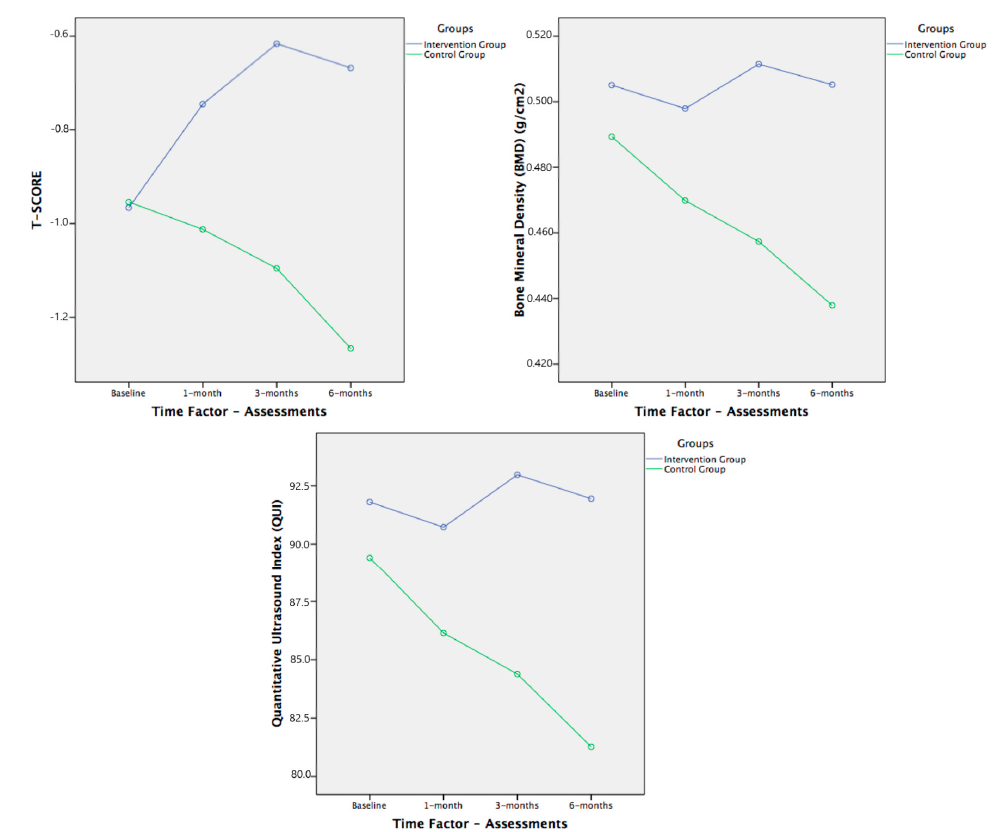
Figure 5. Within-group behavior and follow-up of T-score, bone mineral density (BMD), and quantitative ultrasound index (QUI). Comparisons between both groups (no significant models in MANOVA